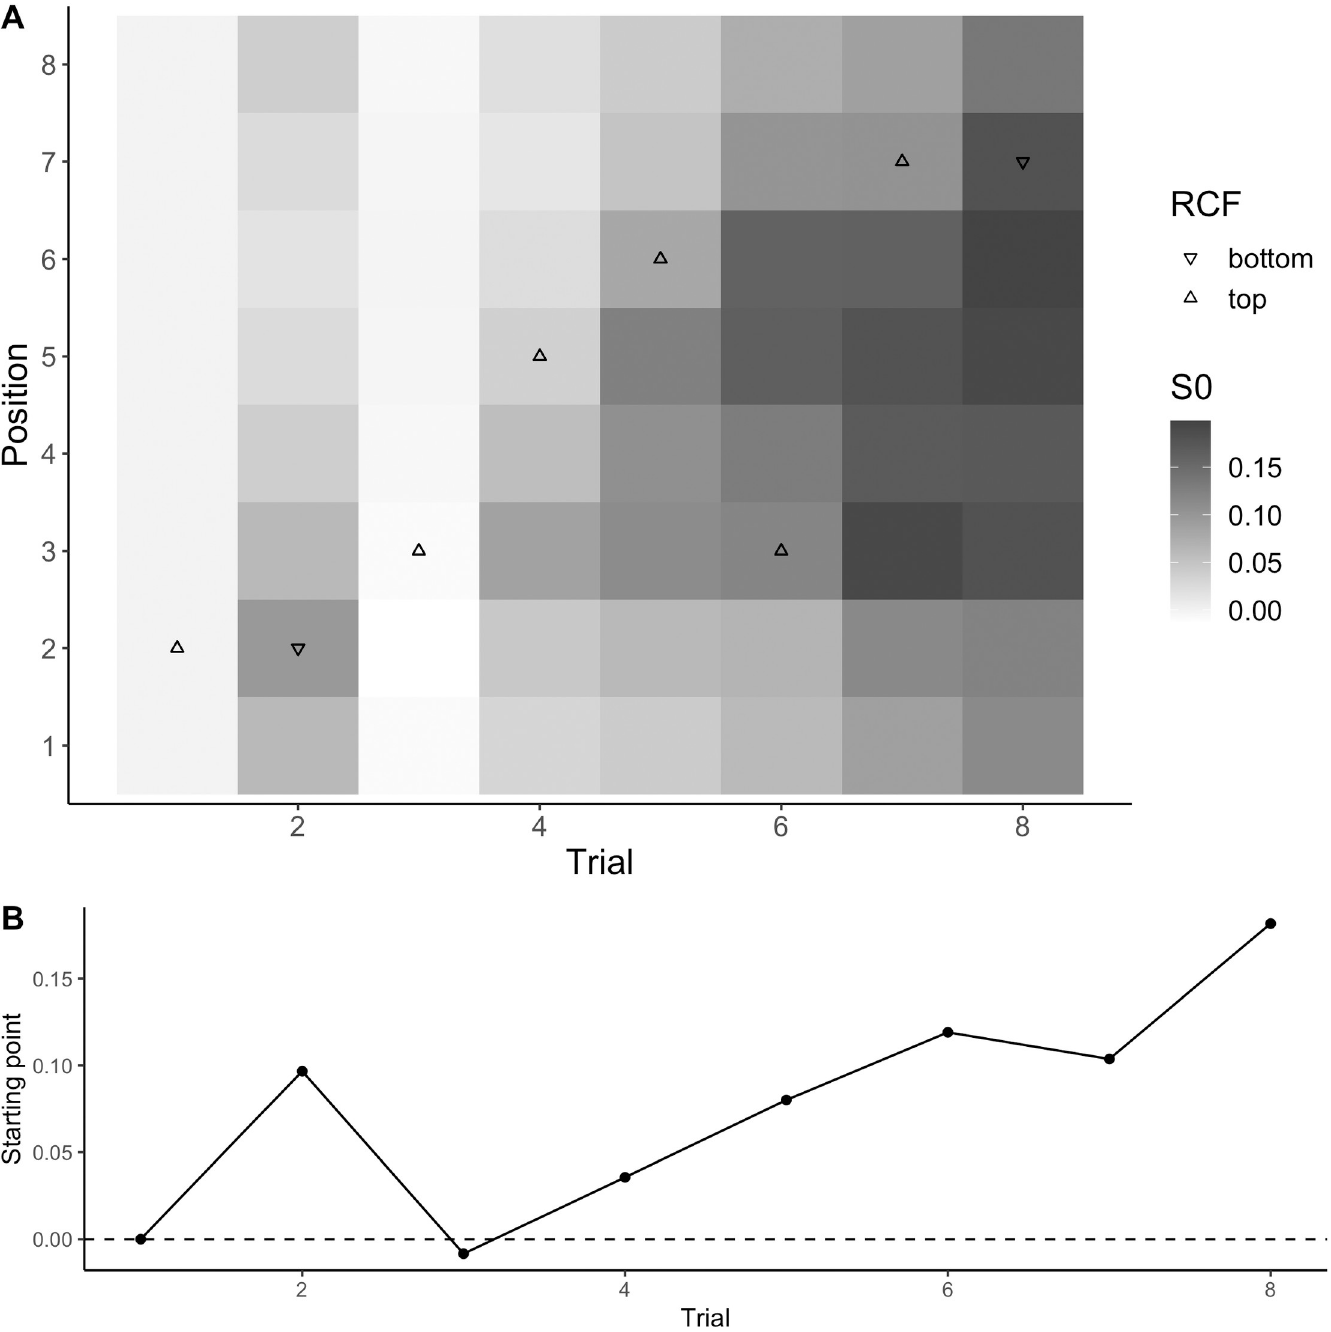
Fig 12. Example of response-based updating. Example of the starting point changes associated with the different positions predicted by the gradient-like dependence on the change of position (i.e., “PG Bayesian S0” updating rule) for the first eight trials of a typical participant (A), and the starting point for the target position on the same eight trials (B). The position of the triangles represent the target position on each trial, and the shape of the triangle indicates the response-critical feature (RCF, i.e., whether the notch was on the top or bottom of the target